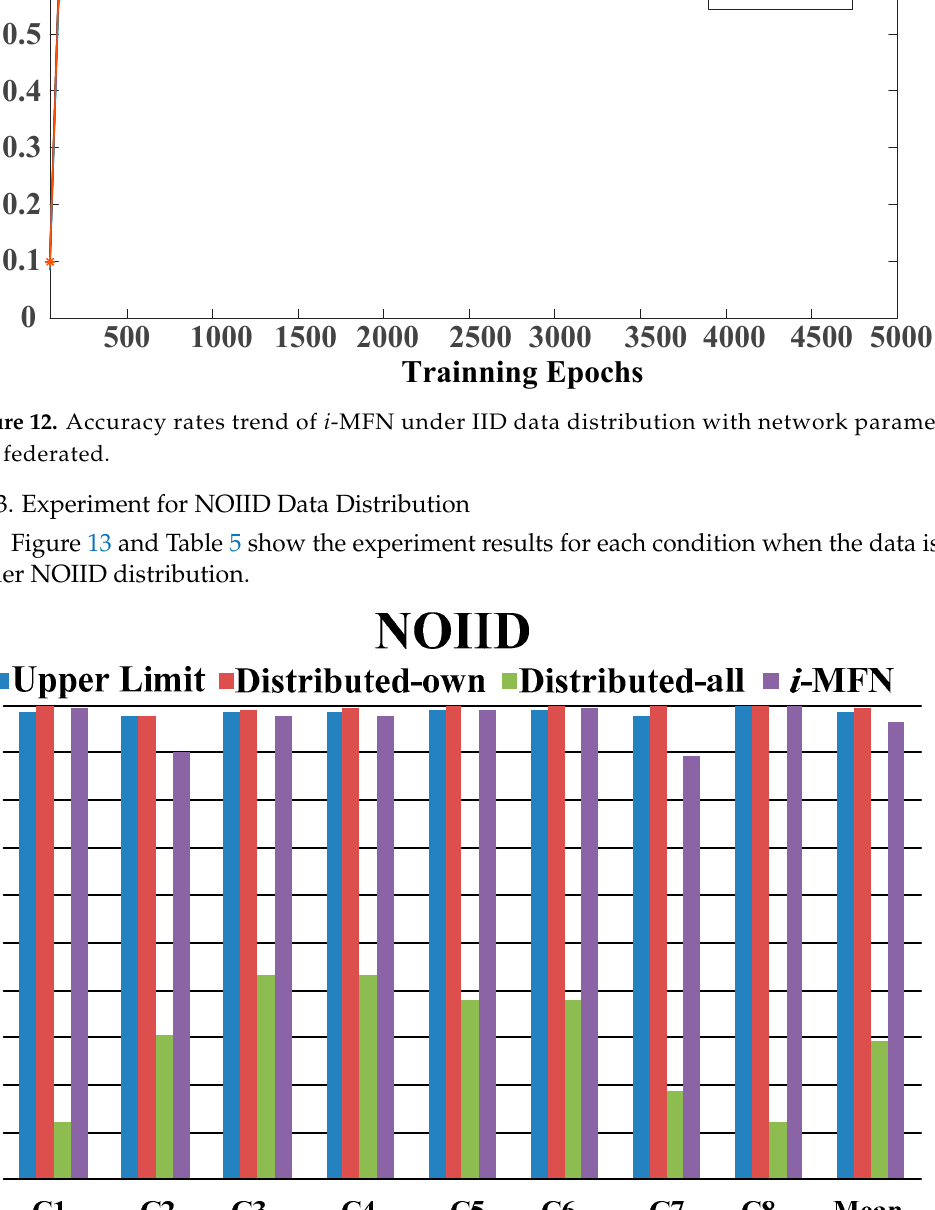
Figure 13. Experimental accuracy comparison under NOIID data distribution. Table 5. Comparison of diagnostic accuracy under NOIID distribution